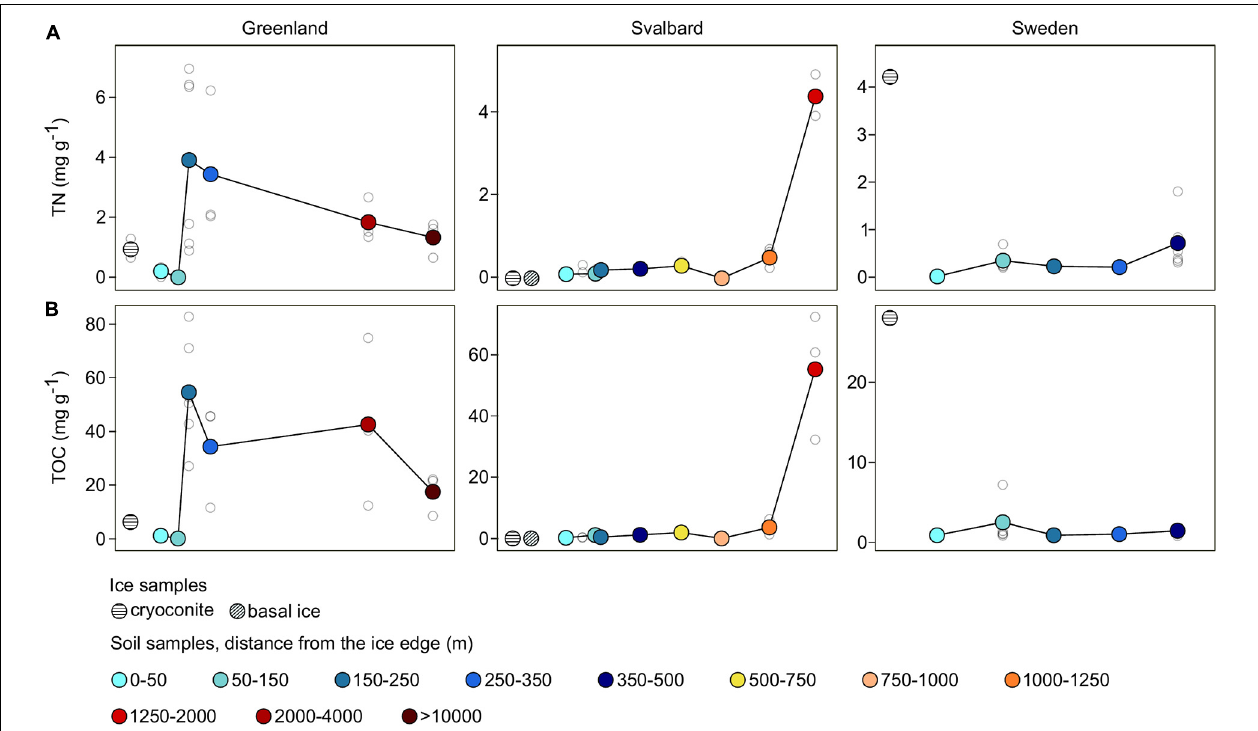
FIGURE 2 | Total nitrogen (TN) (A) and total organic carbon (TOC) (B) trends across the three different proglacial systems. Samples were grouped into different categories and colored in relation to sample distance from the ice edge. Colored dots indicate the average values for each distance, whereas white dots are the values of the individual samples.